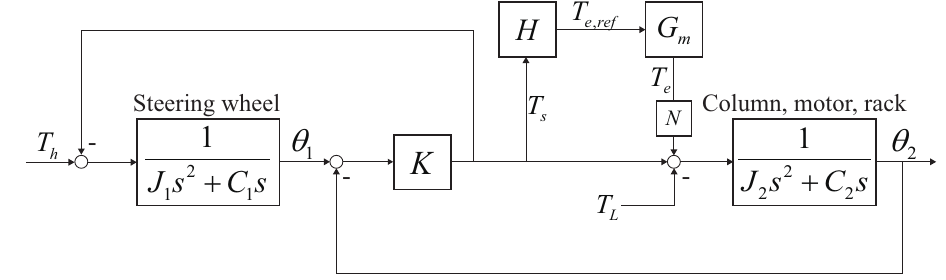
Figure 2. A block diagram of an EPS system.